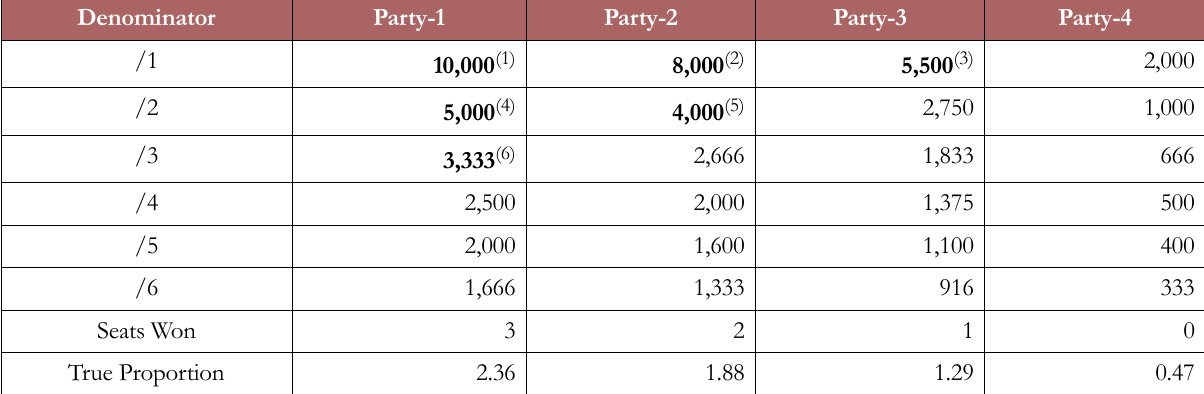
Table 1. Illustration of the D’hondt